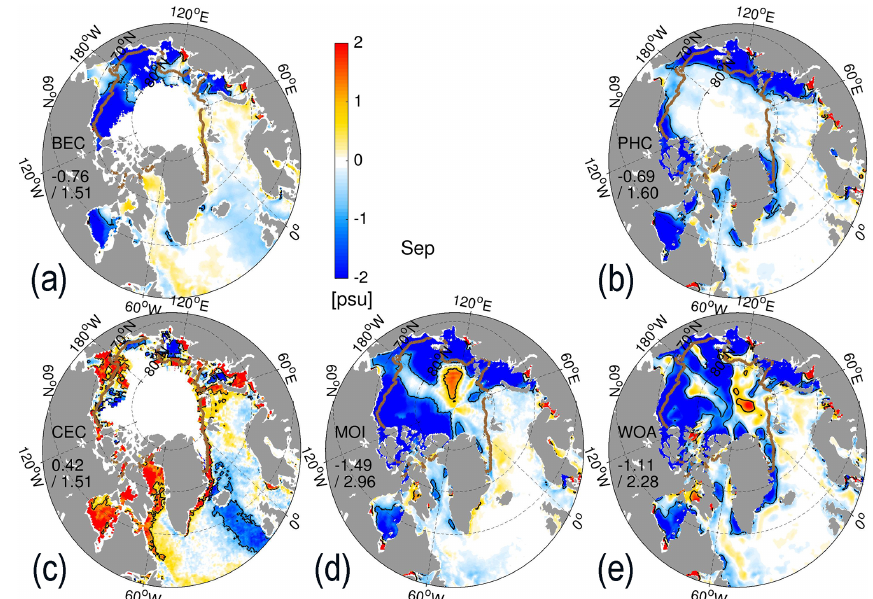
Figure 5. Same as previous figure but for